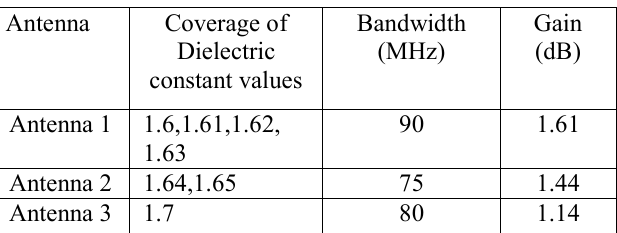
Fig 1.13 S 11 Response of the Antenna 3